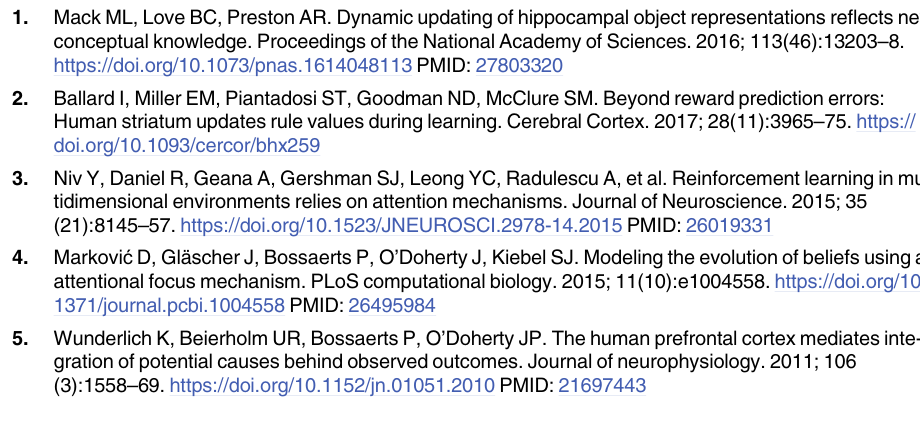
for the hypotheses consistent with the task instructions (darker red bars). In unknown games, more complex hypotheses were deemed a priori more likely. S3 Fig. Learning curves for data and all model simulations. Top and fourth rows are identi- cal to Figs 2A, 2B, 4B and 4C, respectively. S4 Fig. Variants of the serial hypothesis-testing (SHT) model. (A) A diagram of the SHT models compared in the main text. Different variants for each model assumption are presented in colored boxes: in gray are the assumptions adopted by the baseline model; colors denote the different variants tested. (B) Difference in average likelihood per trial between variants of the SHT models and the baseline value-based SHT model. Each model except the full model is only different from the baseline model by one assumption as noted in the label; the full model adopts the better alternative in every assumption. Bar colors correspond to those in panel A, except for the full model (in white). Specifically, the purple bar corresponds to the random- switch SHT model. Error bars represent ± 1 s.e.m. across participants. S1 Text. Inference in the serial hypothesis-testing